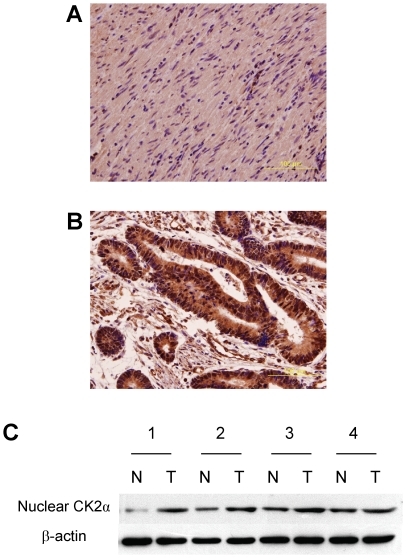
Expression of nuclear CK2α in colorectal tissues.Nuclear CK2α expression in non-tumor and tumor tissues, analyzed by
immunohistochemistry, was shown in Panel A and
B, respectively. Magnification: 400×. Panel
C. Nuclear CK2α expression in four non-tumor/tumor pairs
was examined by Western blot.